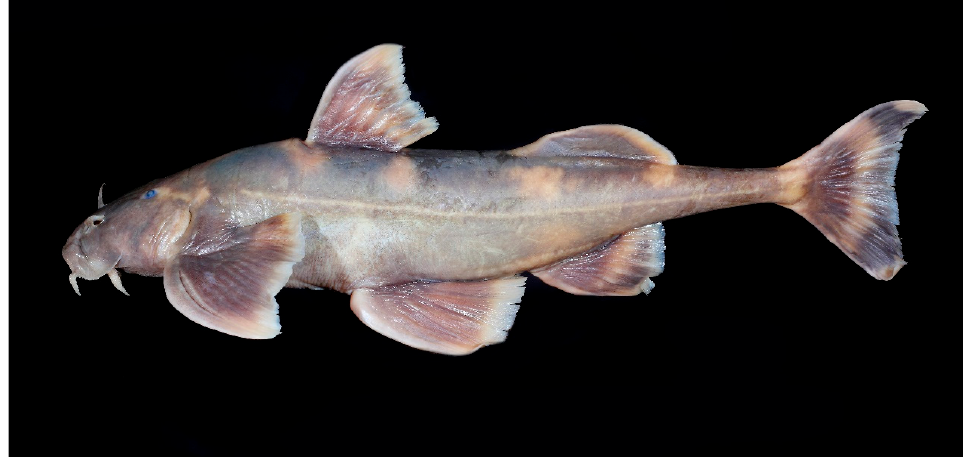
Figure 2. Pseudecheneis sulcatus (184 mm in TL and 54.1 g in TW) collected from the lower Yarlung Zangbo